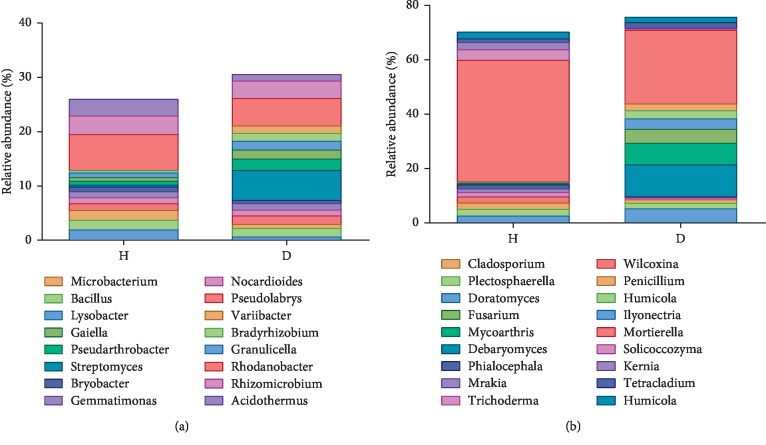
Taxonomic classification at the genus level of bacterial (a) and fungal (b) reads retrieved from healthy and rusty root-affected Panax ginseng. H: healthy plants; D: diseased plants.